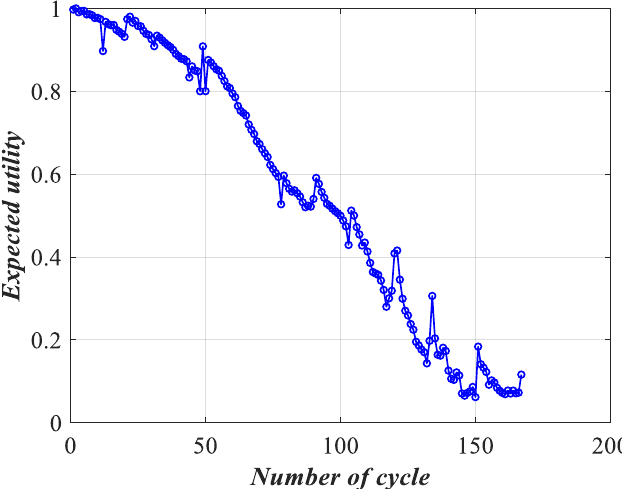
Figure 8. Expected utility of lithium-ion battery performance.